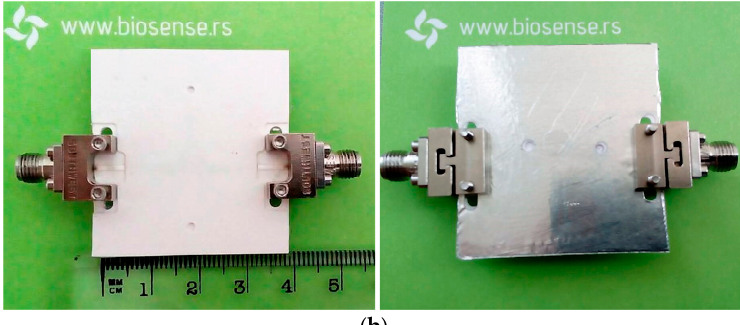
Figure 8. ( a ) The layout of the sensor after the lamination process; ( b ) The layout of the fabricated sensor—top and bottom view.